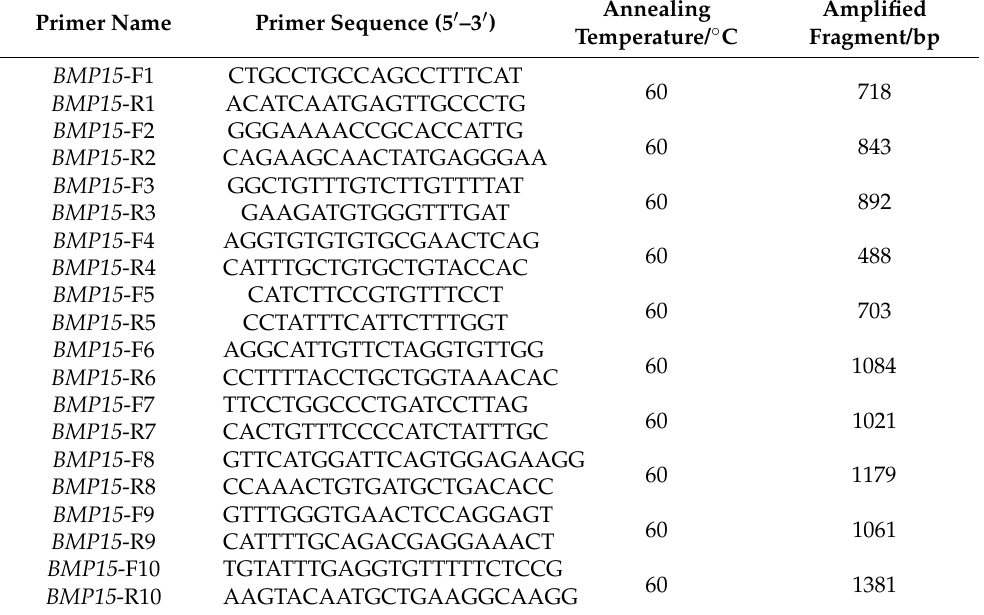
Table 1. Amplification primers for the BMP15 gene in Luzhong mutton